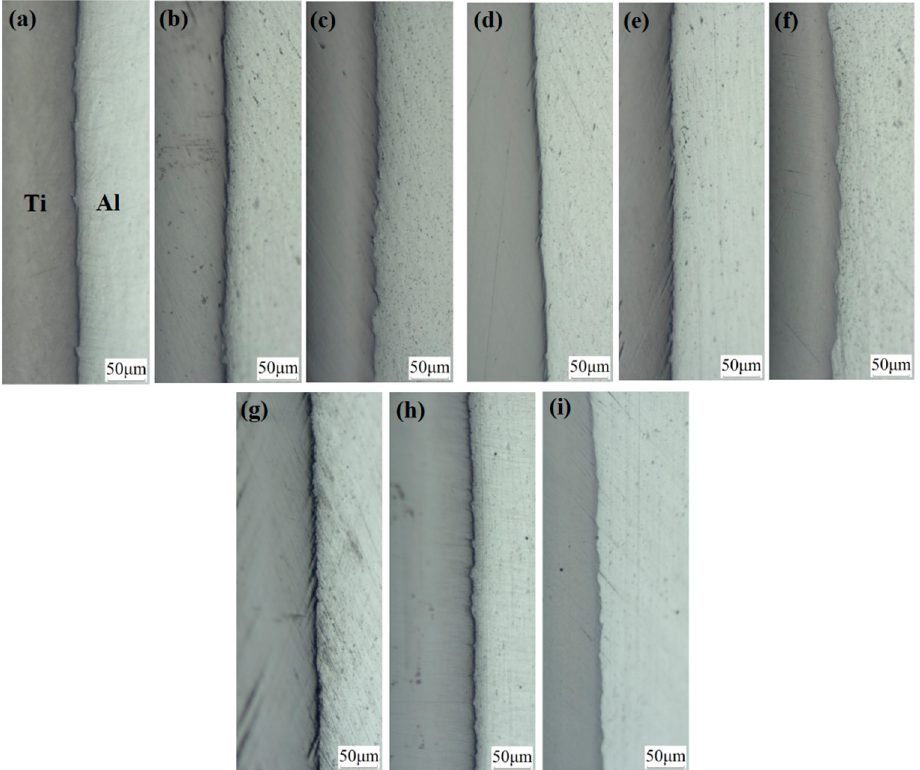
Figure 13. Optical micrograph of the interface of the Ti/Al composite sheet. ( a ) Specimen B1; ( b ) specimen B2; ( c ) specimen B3; ( d ) specimen A1; ( e ) specimen A2; ( f ) specimen A3; ( g ) specimen C1; ( h ) specimen C2; ( i ) specimen C3.